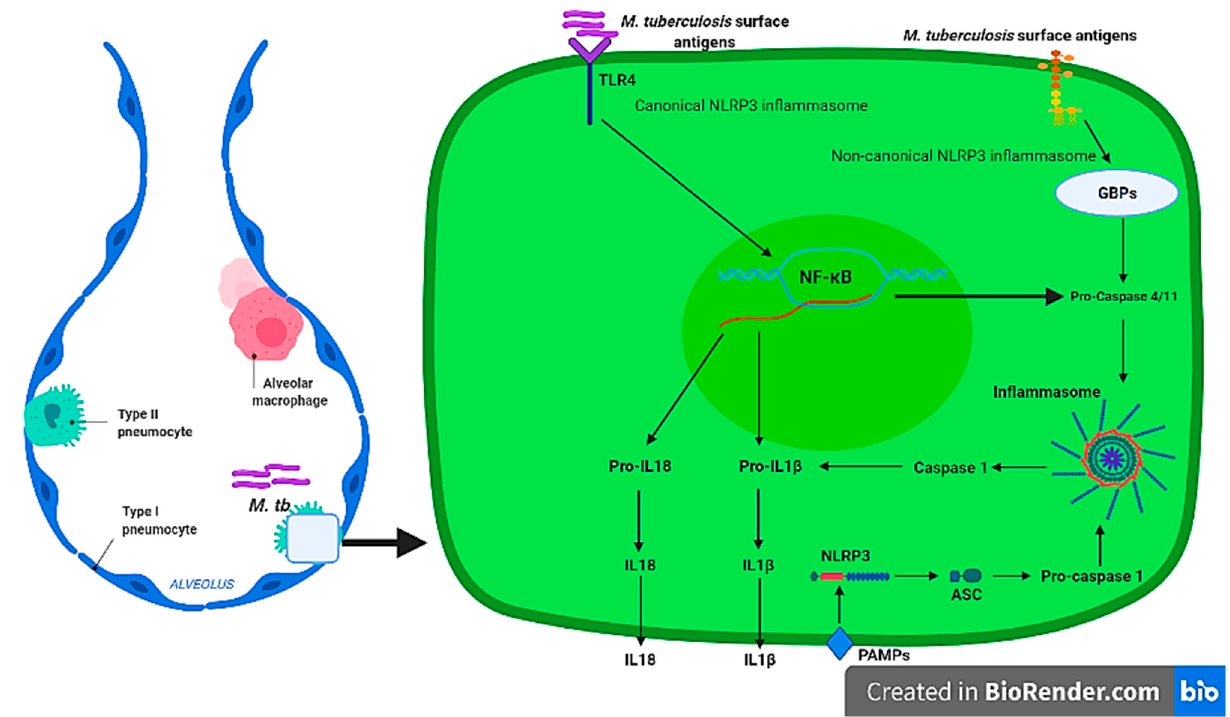
Figure 1. Overview of the alveolar NLRP3 inflammasome activation on alveolar innate cells during M. tuberculosis infection. The host PRRs (TLR4) is activated by M. tuberculosis surface PAMPs stimulate the NF-kB transcriptional factor to transcribe IL1 , IL18 , and CASP4/11 that are processed by activation of the inflammasome complex through NLRP3 and CASP1. Image was created in BioRender.com (accessed on 23 August 2021).